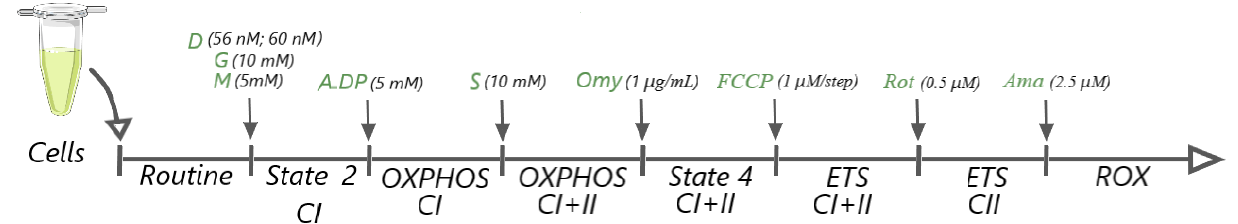
Figure 2. HRR protocol for permeabilized A375 and A549 cell lines. D: digitonin—a mild detergent; G: glutamate—CI substrate; M: malate—CI substrate; ADP: adenosine diphosphate; S: succinate—CII substrate; Omy: oligomycin—complex V inhibitor; FCCP: carbonyl cyanide p-(trifluoromethoxy) phenyl-hydrazone—a protonophore; Rot: rotenone—CI inhibitor and Ama: antimycin A—CIII inhibitor.